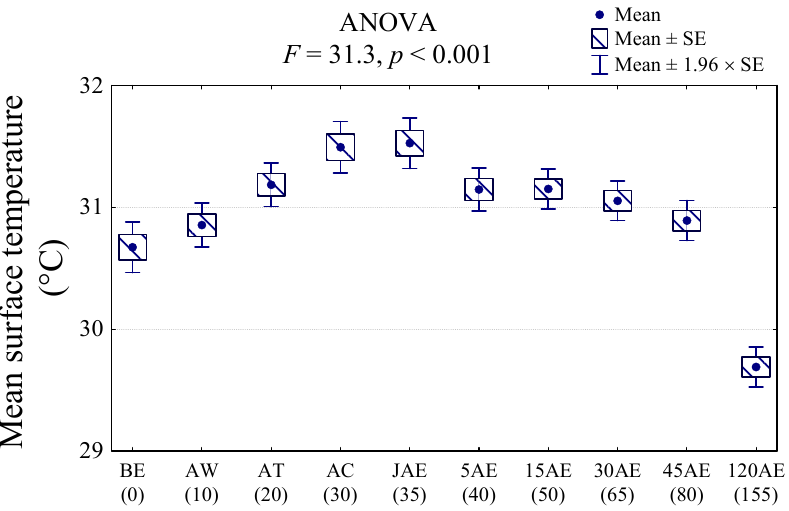
ANOVA F = 31.3, p < 0.001